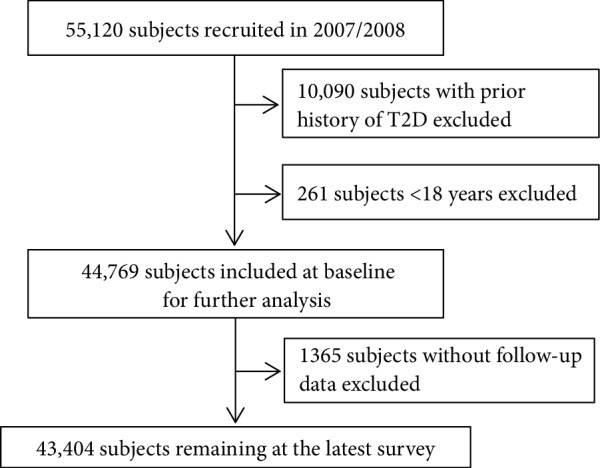
Study population selection flowchart.